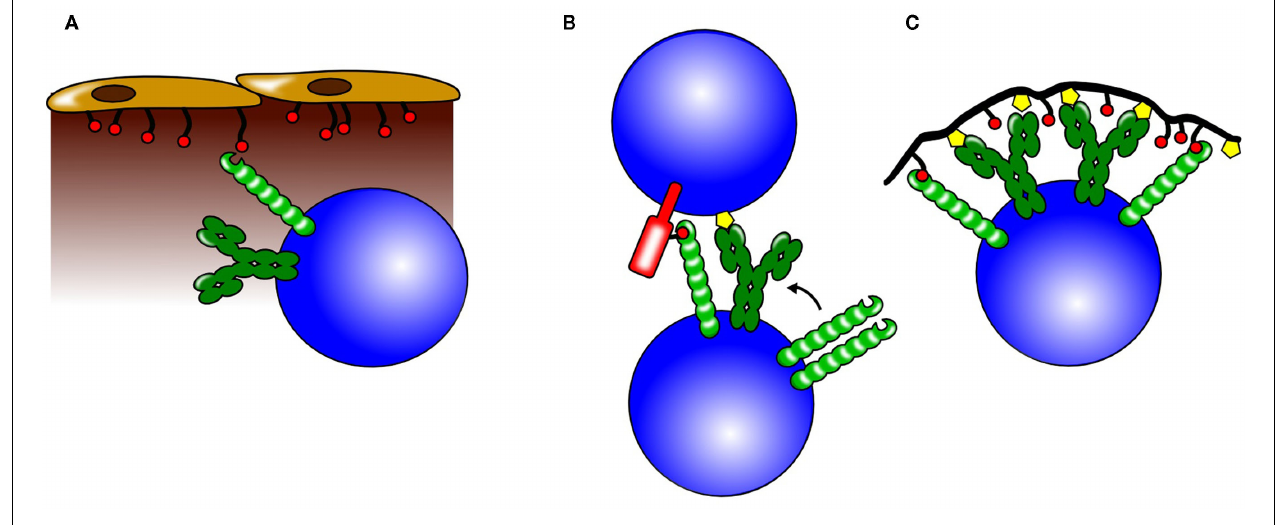
opposing cell. Increased colocalization of CD22 and BCR molecules could lead to a stronger CD22-mediated inhibition. (C) Antigens engaging the BCR (yellow symbols), but also containing sialic acids (red circles) recruit CD22 to the BCR.This leads to a stronger inhibition of the BCR signal and might be one of the mechanisms how tolerance to self-antigens containing CD22 ligands is